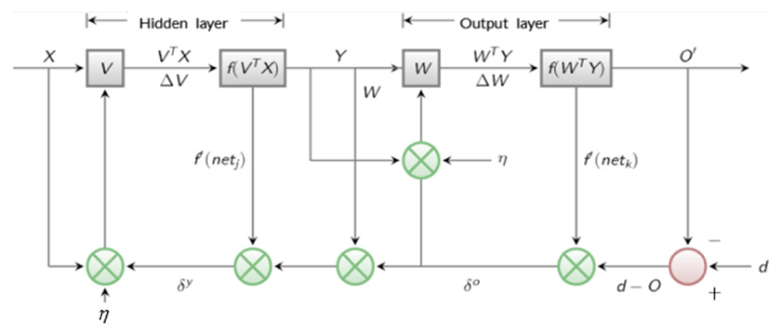
Figure 4. Signal flow diagram of BP algorithm [18].